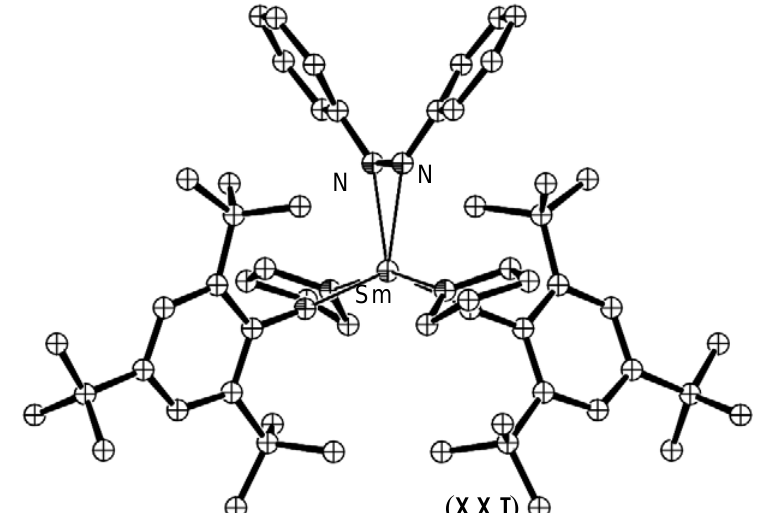
Me )Sm{( η 6 : η 1 -Ph) BPh }(PhNNPh)], ( XXIII ) [52]. 5 5 2 2